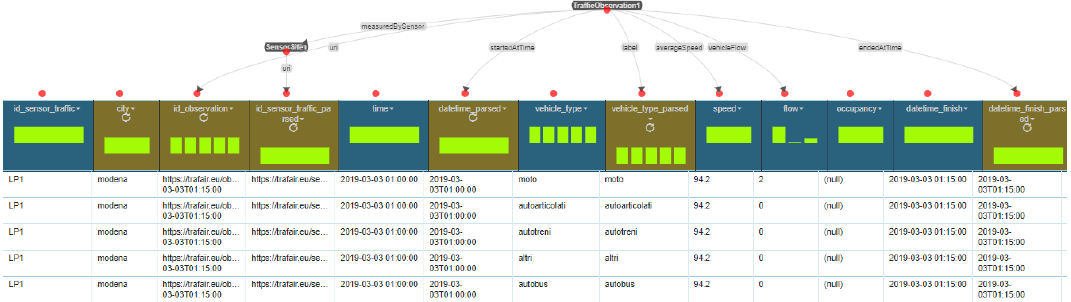
Figure 8. Karma model implemented to transform data from the “sensor_traffic_observation” table (Figure 3) into Linked